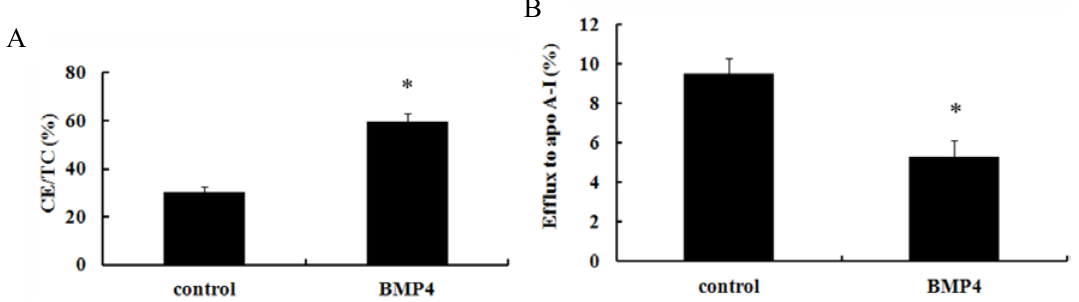
Figure 2. Effect of BMP4 to cellular lipid. Cellular lipid was extracted, and free cholesterol (FC) and total cholesterol (TC) were analyzed by HPLC. CE and the CE/TC ratio were calculated. ( A ) CE:TC ratios in macrophage cells after fatty acid treatments with or without BMP4 (4 ng/L) for 48 h; ( B ) cholesterol efflux in macrophage cells after fatty acid treatments with or without BMP4 (4 ng/L) for 48 h. * p < 0.05. A